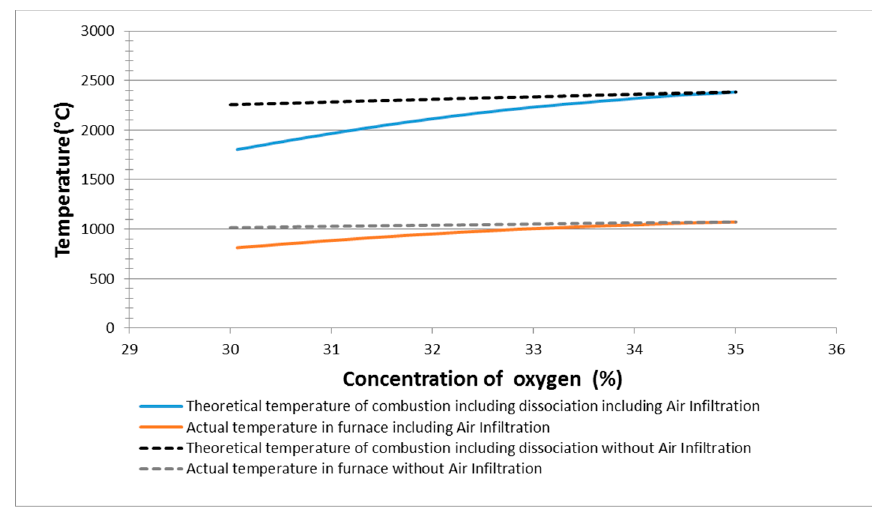
Table 5. Axial distances of individual thermocouples from the burner. Figure 9. Dependence of temperature change with air infiltration. Figure 9. Dependence of temperature change with air infiltration.